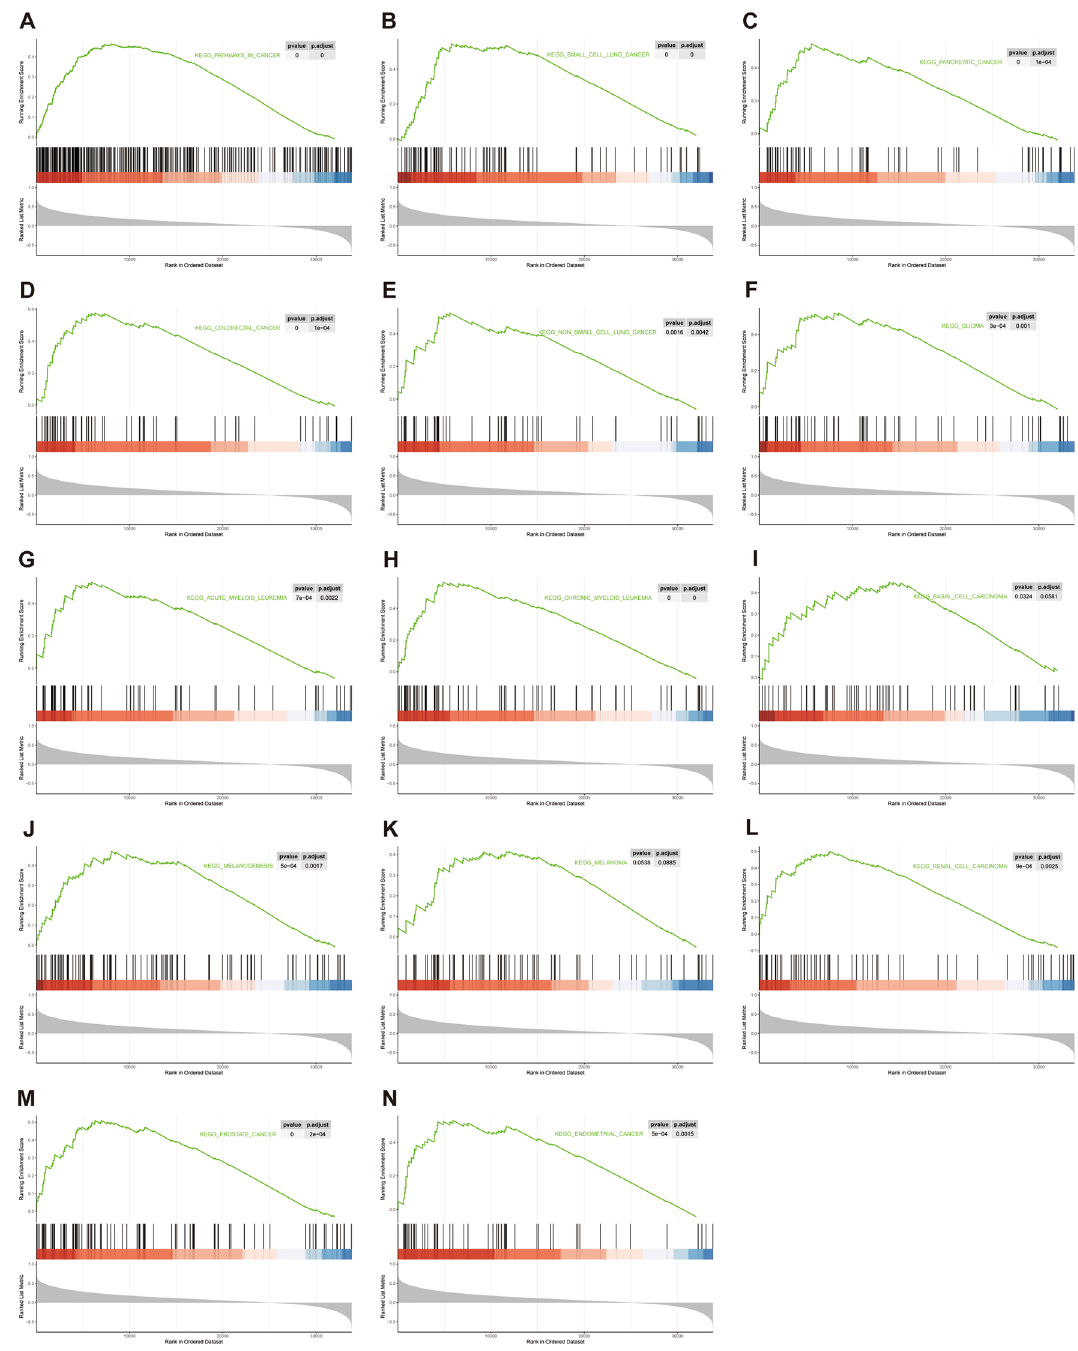
Figure 3. Cancer related clusters were enriched in GSEA analysis. Pathways in ( A ) cancer, ( B ) small cell lung cancer, ( C ) pancreatic cancer, ( D ) colorectal cancer, ( E ) non-small cell lung cancer, ( F ) glioma, ( G ) acute myeloid leukemia, ( H ) chromic myeloid leukemia, ( I ) basal cell carcinoma, ( J ) melanogenesis, ( K ) melanoma as well as for ( L ) renal cell carcinoma, in addition, ( M ) endometrial cancer and ( N ) prostate cancer were significantly enriched as